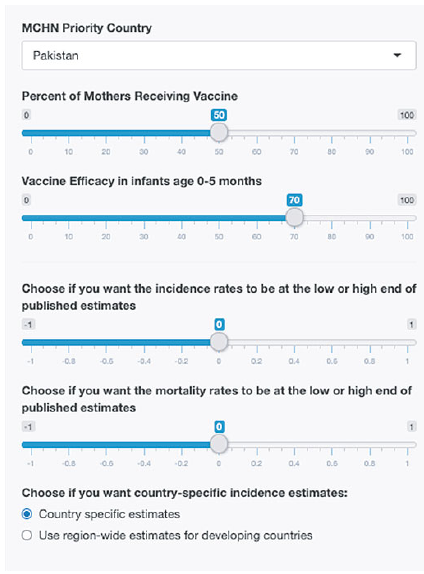
Figure 4: Control panel for interactive tool. The control panel of the web-based interactive tool that is used to assess the e ffi cacy of candidate maternal RSV vaccination implementation at reducing infant disease incidence and mortality in developing countries is depicted. The user selects a country from the USAID MCHN priority countries list, the percentage of expectant mothers to receive the vaccine, and maternal vaccine e ff ectiveness at preventing RSV in infants age 0-5 months. The user then chooses if they want incidence and mortality rates to be calculated using the low or high end of published estimates. Finally, the user selects if they prefer data to be displayed by country-speci fi c or region- wise